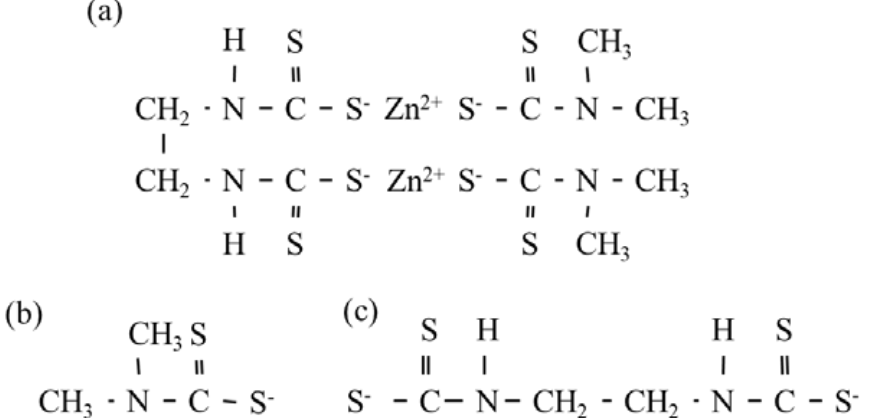
Figure 1. Structural formulas of ( a ) polycarbamate (PC) and its main degradation products, ( b ) dimethyldithiocarbamate (DMDC) and ( c ) ethylenebisdithiocarbamate (EBDC).